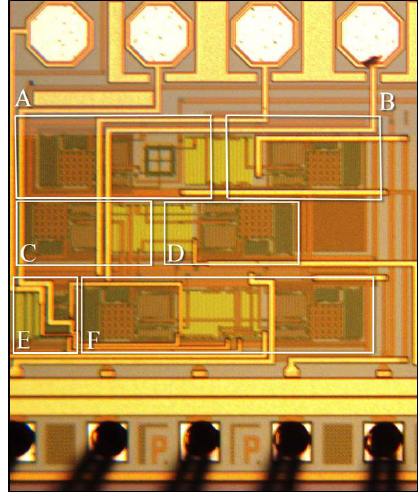
Figure 14. Fabricated